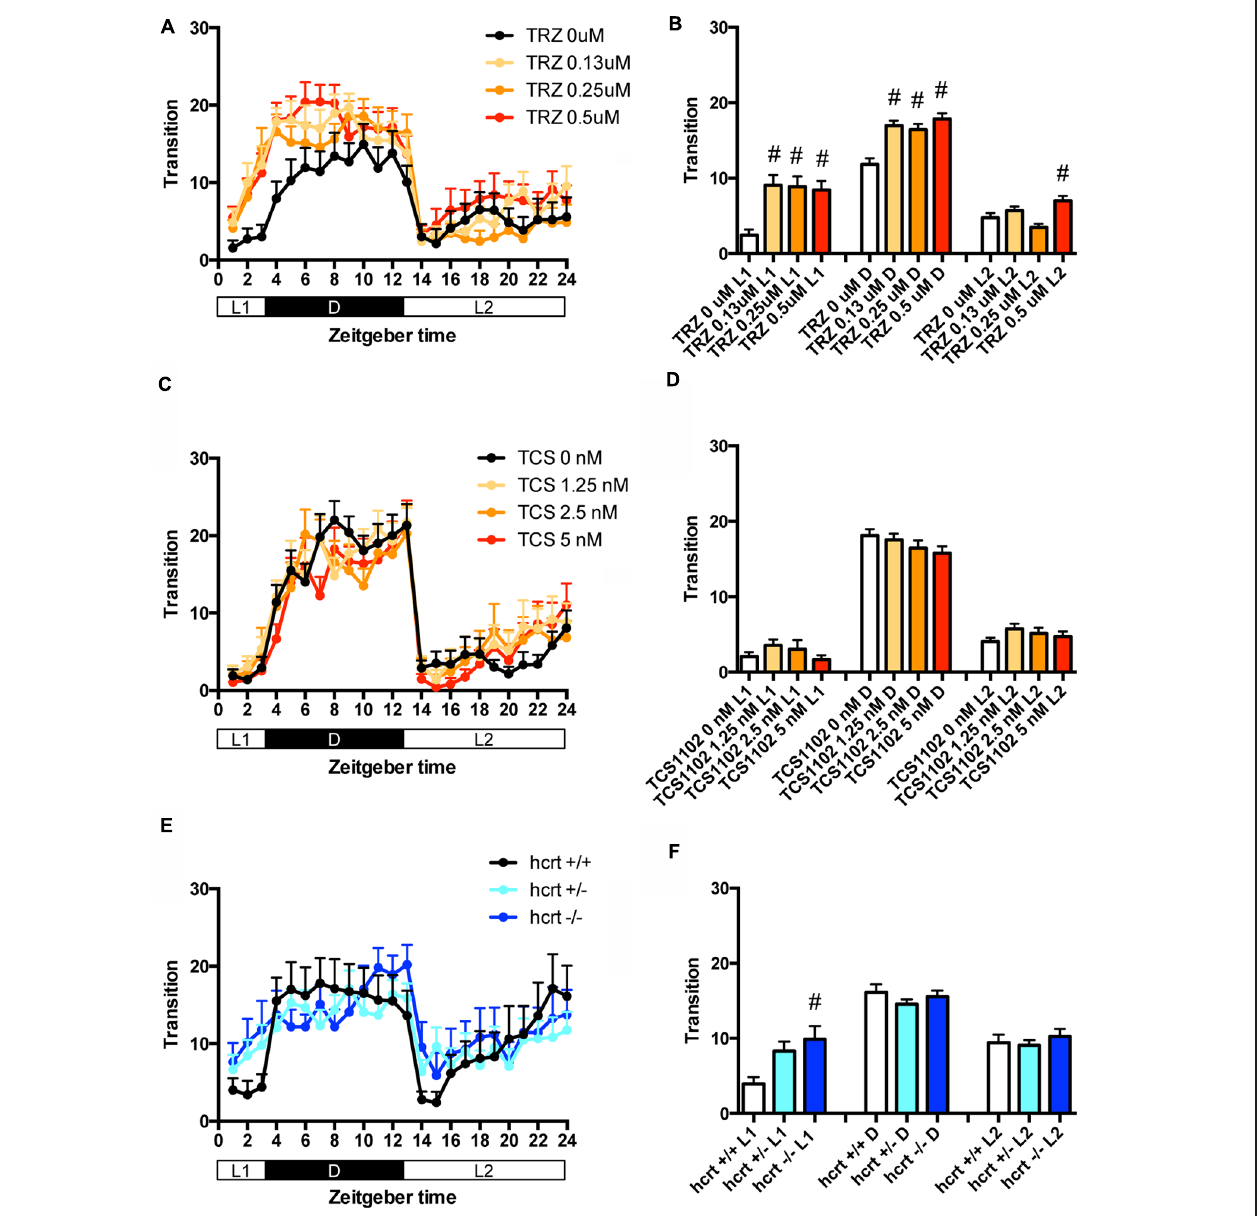
FIGURE 3 | Effects of triazolam, TCS1102, and hcrt knockout on the transition between rest and active states of zebrafish. The number of transitions of zebrafish treated with triazolam (A) , TCS1102 (C) , and hcrt knockout (E) from 9 to 10 dpf are shown during the hour. The number of transitions of zebrafish treated with triazolam (B) , TCS1102 (D) and hcrt knockout (F) from 9 to 10 dpf are shown during L1, D, and L2. The data are represented as means with the standard error of mean. # p < 0.05 vs.